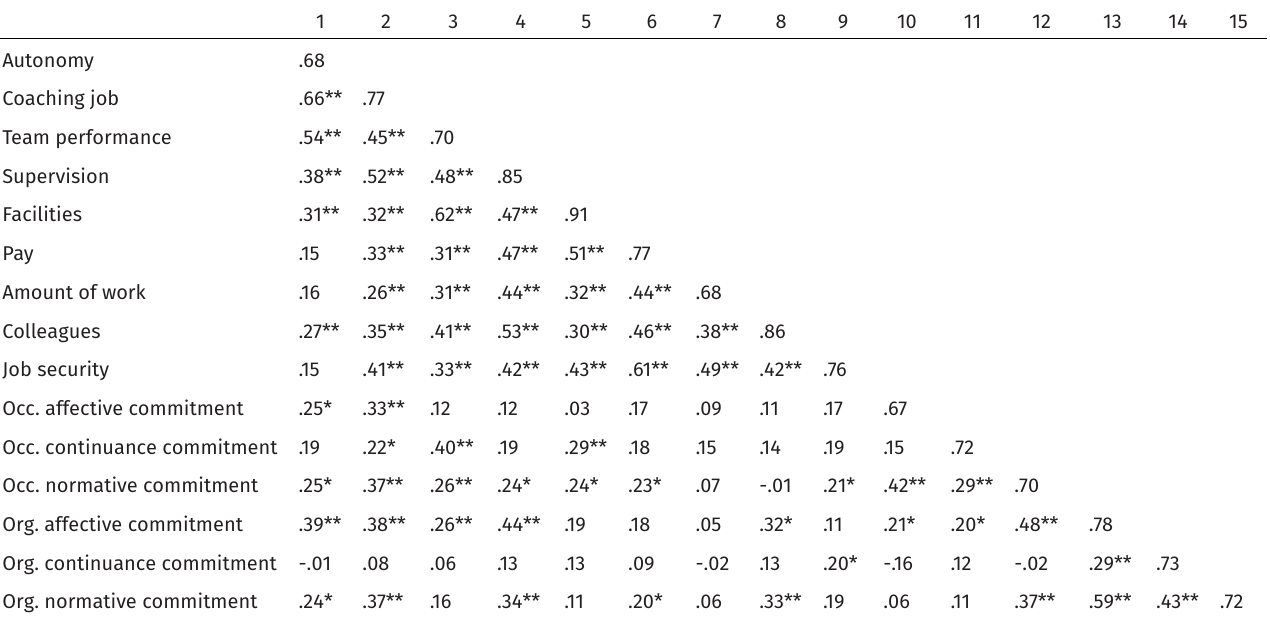
Table 2. Correlations between all the depended variables and Conbach’s α of the scales in the